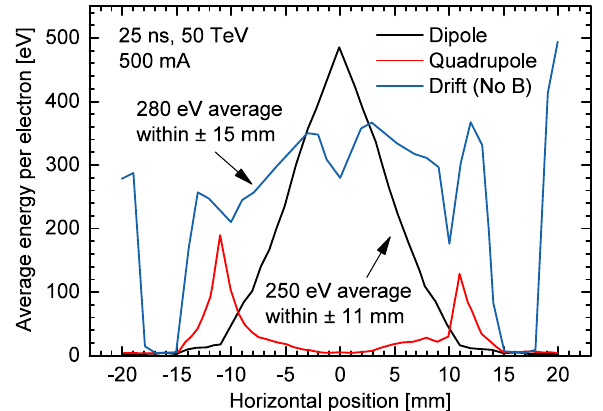
FIG. 11. Average electron impact energy in a dipole and drift space with SEY ¼ 1 . 4 , and in a quadrupole with SEY ¼ 1 . 1 . 50 TeV, 500 mA, 25 ns beam. Drift space without magnetic field